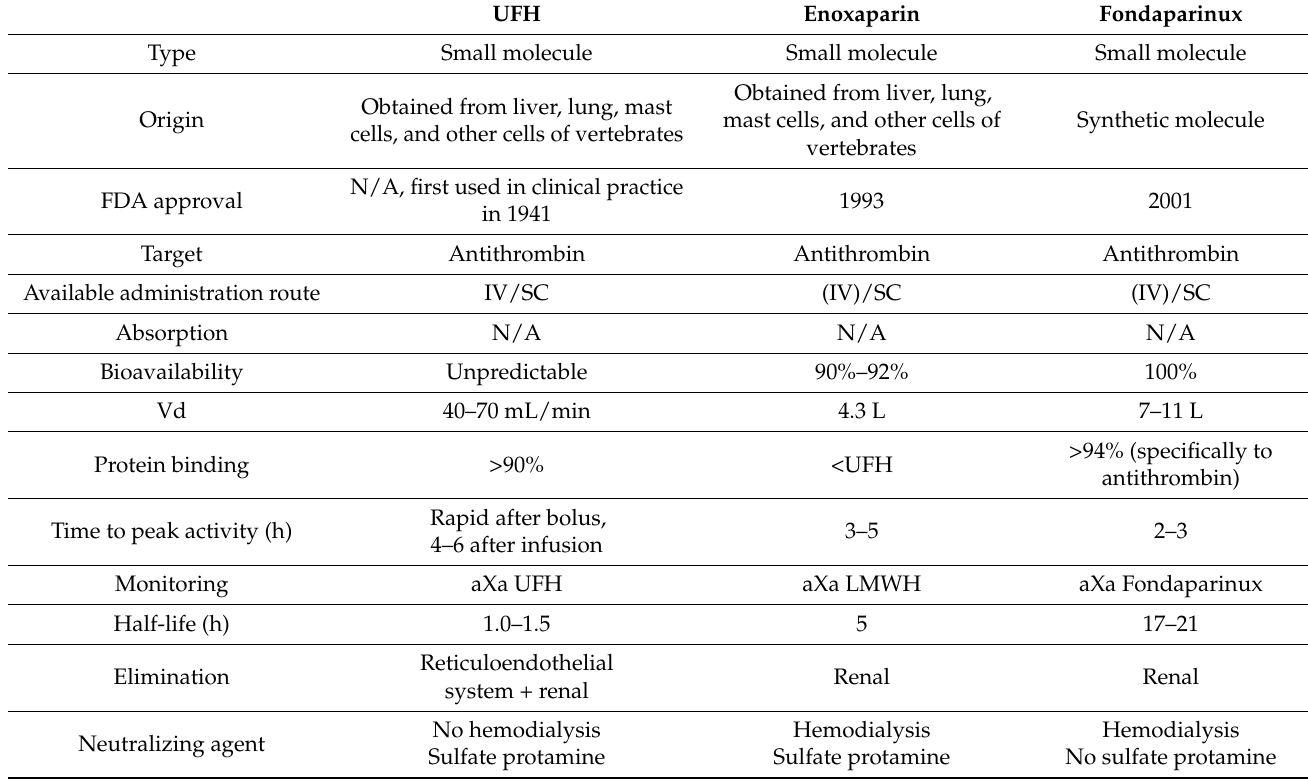
Table 1. Pharmacokinetics of UFH, enoxaparin, and fondaparinux. Other LMWHs have similar pharmacological characteristics as enoxaparin, the most frequently used. UFH: unfractionated heparin, Vd: volume of distribution, IV: intravenous, SC: subcutaneous. UFH Enoxaparin